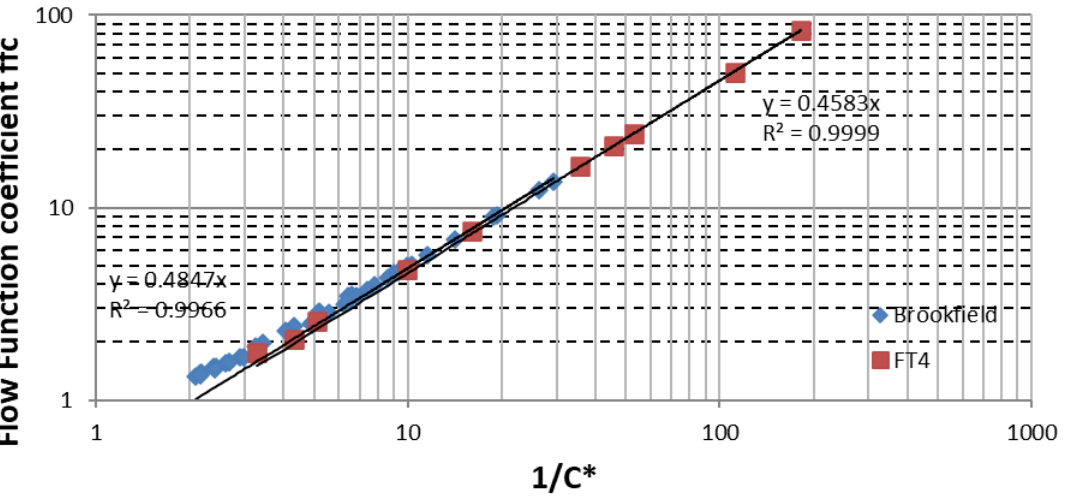
Figure 14. Plot of ffc vs. 1/C* to find the equipment constant E for the Brookfield PFT and Freeman FT4.